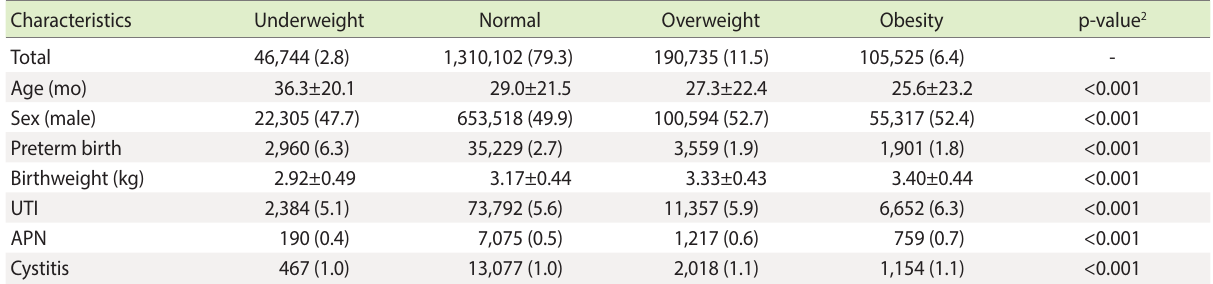
Figure 1. Flow chart of study enrollment. ICD-10, International Classification of Dis eases, 10th revision; UTI, urinary tract infection; APN, acute pyelonephritis. Table 1. Baseline characteristics and incidence of outcomes according to weight status categories 1